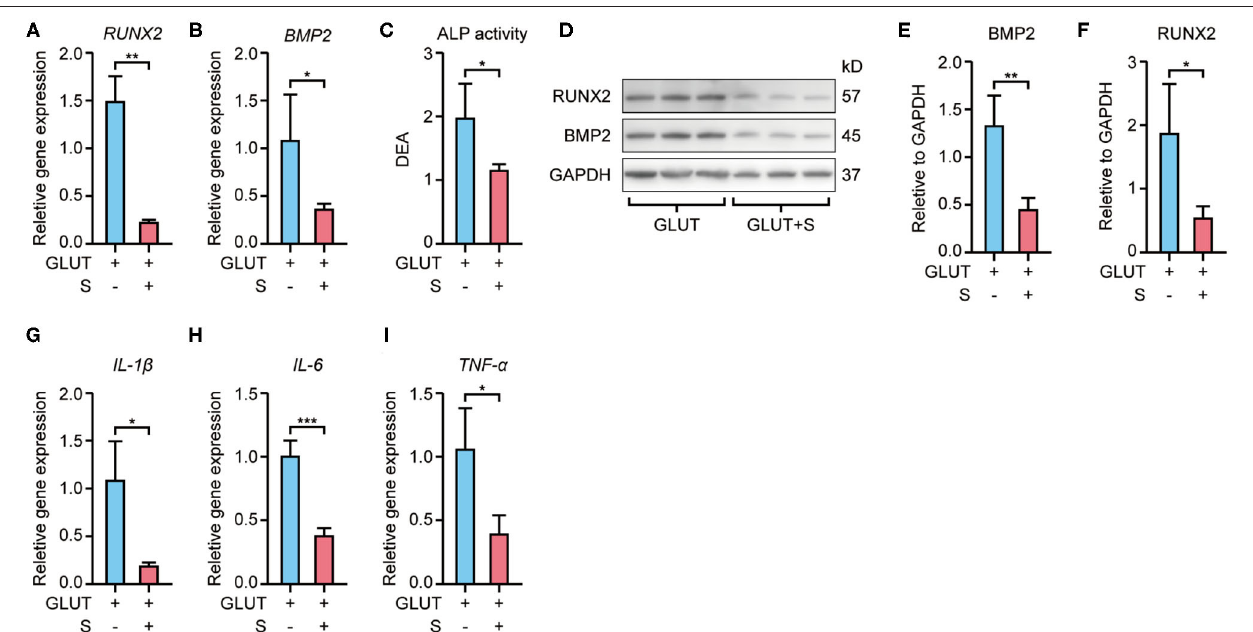
FIGURE 4 | Expression of osteoblast and inflammatory markers of GLUT BHVs in implant and implant + S groups 56 days after implantation. (A,B) Sevelamer reduces Runx2 and Bmp2 mRNA levels. (C) Sevelamer reduces ALP activity. (D–F) Protein expression of RUNX2 and BMP2 quantification analysis (E,F) and representative blotting (D) . (G–I) mRNA expression of IL-1 β (G) , IL-6 (H) , and TNF- α (I) decreased in the implant + S group. N = 3 for Western blot, N = 4 for RT-qPCR and ALP activity. GLUT represents GLUT BHVs in the implant group, and GLUT + S represents GLUT BHVs in the implant + S group. Data are mean ± SD, * p < 0.05, ** p < 0.01, *** p < 0.001.